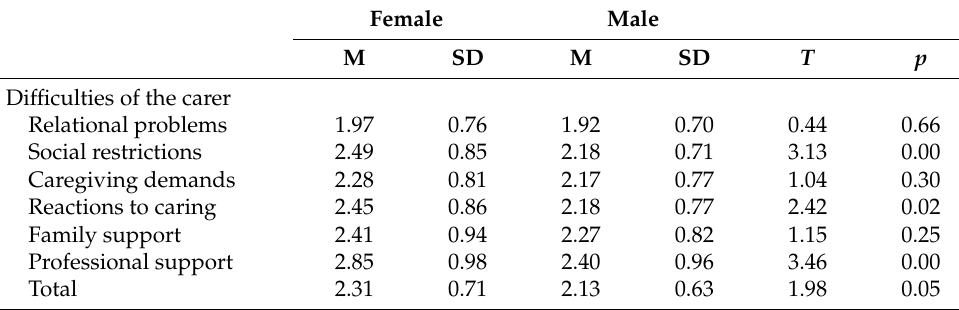
Table 6. Results of the study of caregiver difficulties by gender.